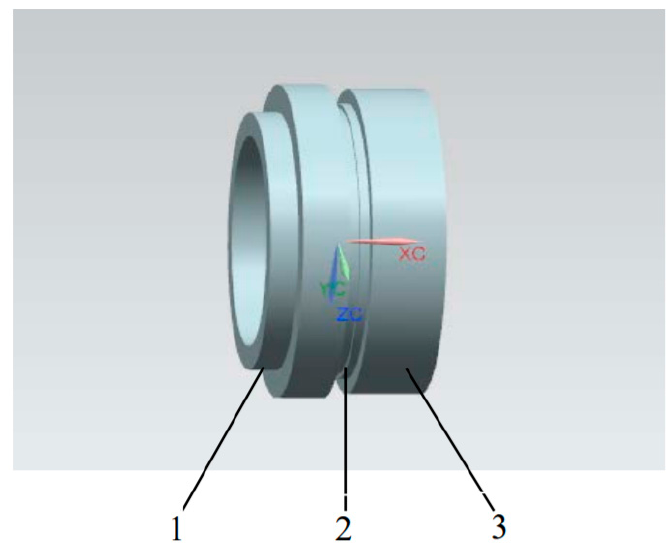
Figure 7. Computational domains of the mechanical seal (1-stationary ring, 2-fluid film, 3-rotating ring).